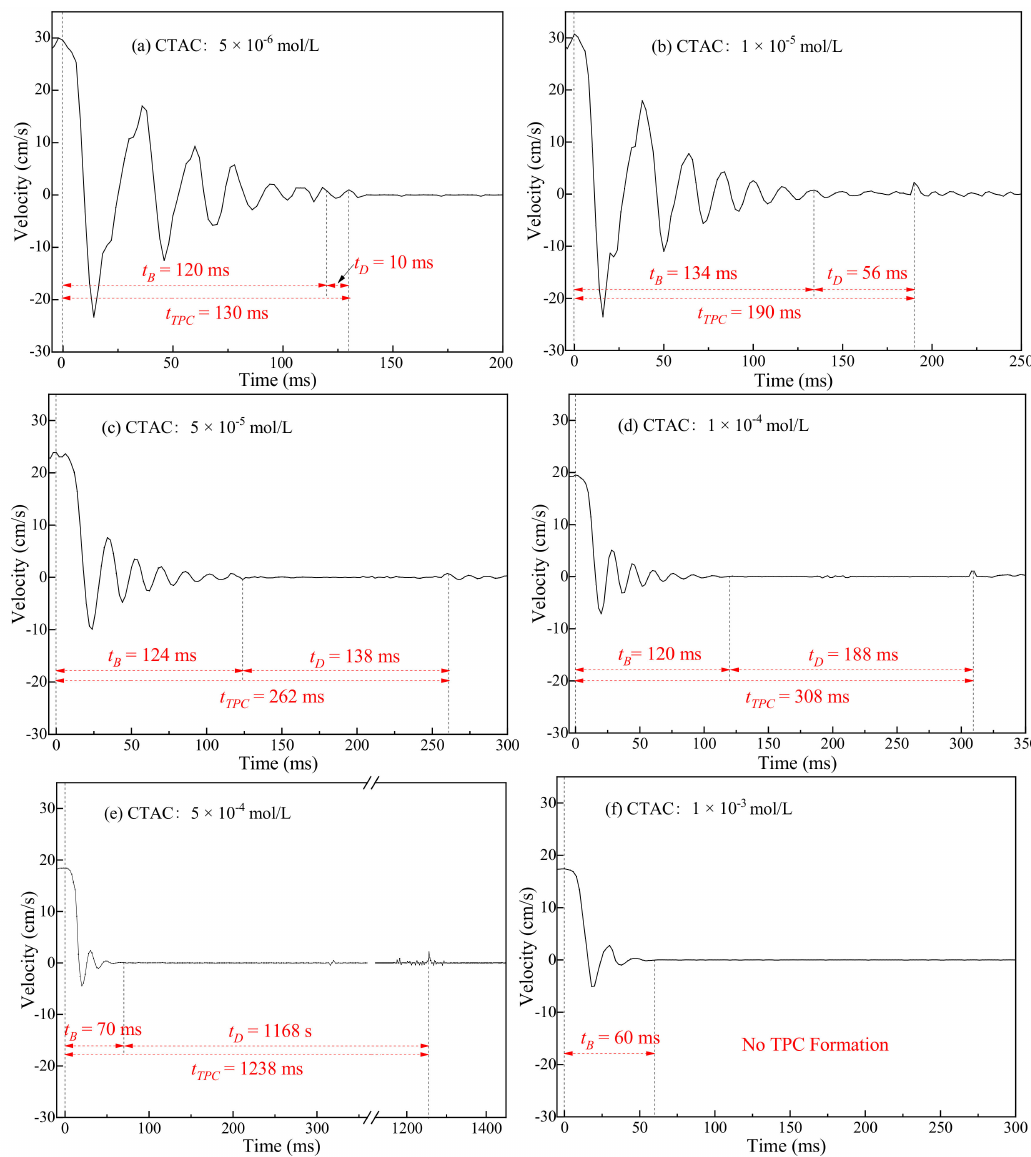
Figure 11. Bubble velocity variation during collision-rebound process with talc surface in CTAC solution with different concentrations. ( a ) 5 × 10 − 6 mol/L; ( b ) 1 × 10 − 5 mol/L; ( c ) 5 × 10 − 5